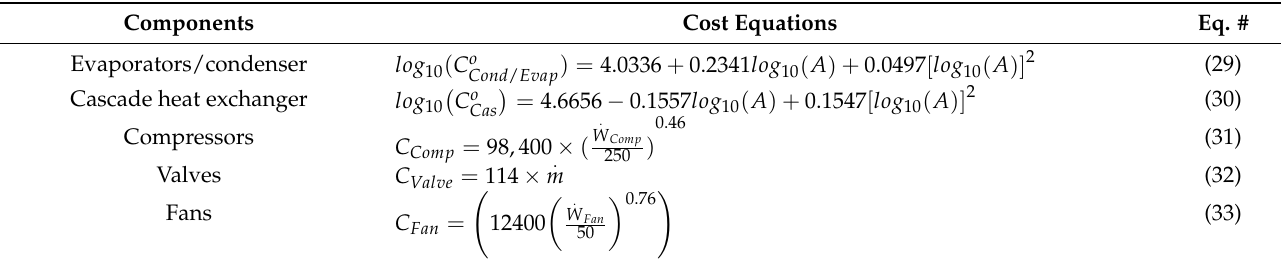
Table 3. Equations used to calculate the capital cost of components [34,35].